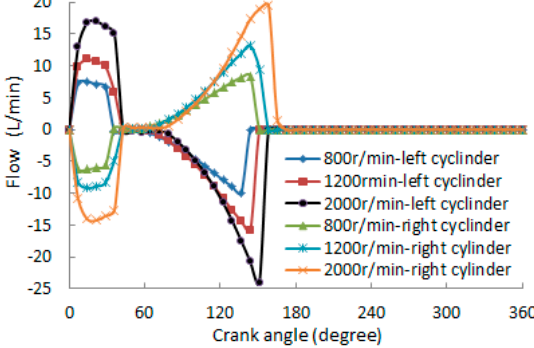
Figure 7. Flow of cylinders at different engine speeds with the same adjustment quantity.